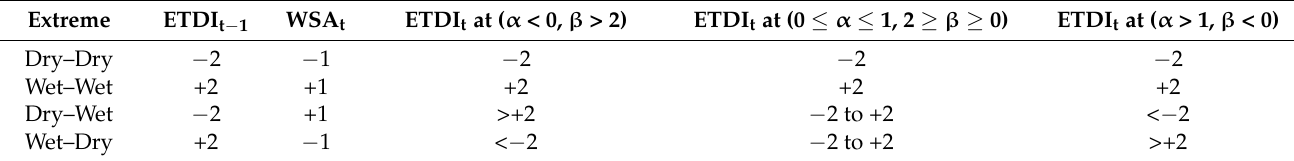
Figure 3. Straight line representing extremely dry and wet conditions using α and β parameters as coefficients of the previous evapotranspiration deficit index and the current water stress anomaly, respectively. Table 1. Evapotranspiration deficit index (ETDI) of a point in time (t) at consecutive extremely dry and wet boundary conditions for three different ranges of (α,β)-parameter combinations. WSA represents water stress anomaly.